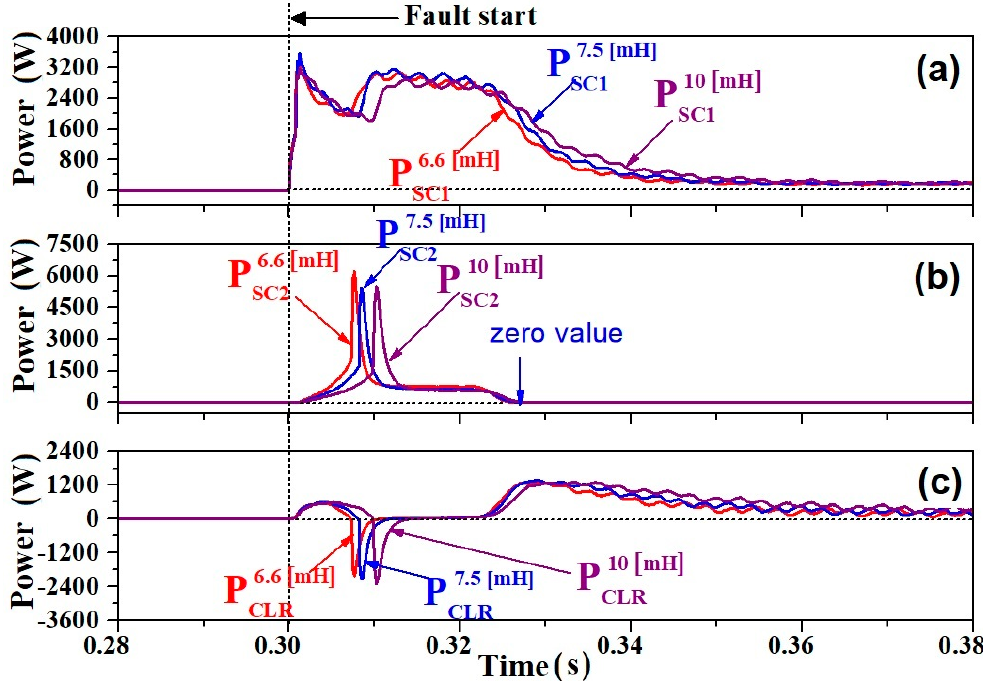
Figure 9. Instantaneous power waveforms due to the CLR’s inductance: ( a ) power burden arising from the R SC1 element depending on the CLR’s inductance; ( b ) power burden arising from the R SC2 element depending on the CLR’s inductance; ( c ) power burden arising from the CLR depending on the CLR’s inductance. Energies 2020 , 13 , x FOR PEER REVIEW